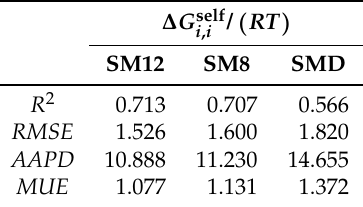
Figure 1. Parity plot of the predicted versus reference values of the negative dimensionless self-solvation free energy, − ∆ G self / ( RT ) , using the SM12, SM8, and SMD universal solvent model, i , i as indicated. The blue lines corresponds to the y = x line, and the dashed blue lines correspond to ± 1.5 and are drawn as a reference; the value of 1.5 was used based on the RMSE for the SM12 predictions. Table 1. A summary of the squared correlation coefficient ( R 2 ), root mean square error ( RMSE ), average absolute percent deviation ( AAPD ), and mean unsigned error ( MUE ) for the values of ∆ G self / ( RT ) predicted using the SM12, SM8, and SMD universal solvent model as compared to i , i the reference